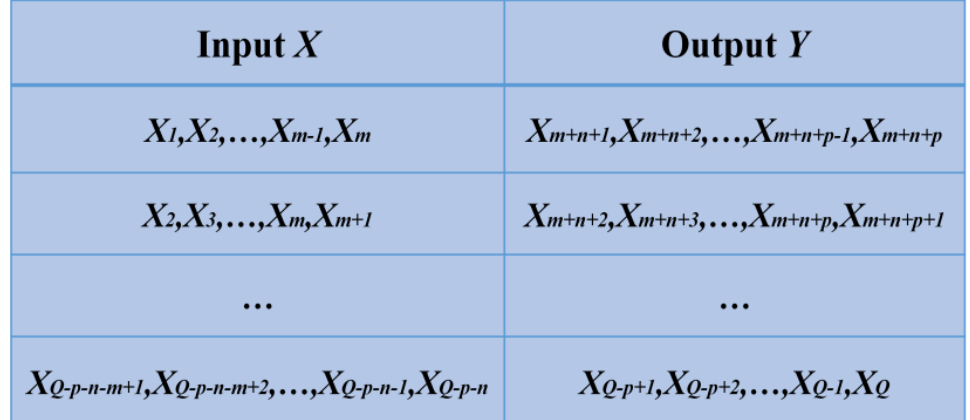
Figure 3. The reconstructed matrix.